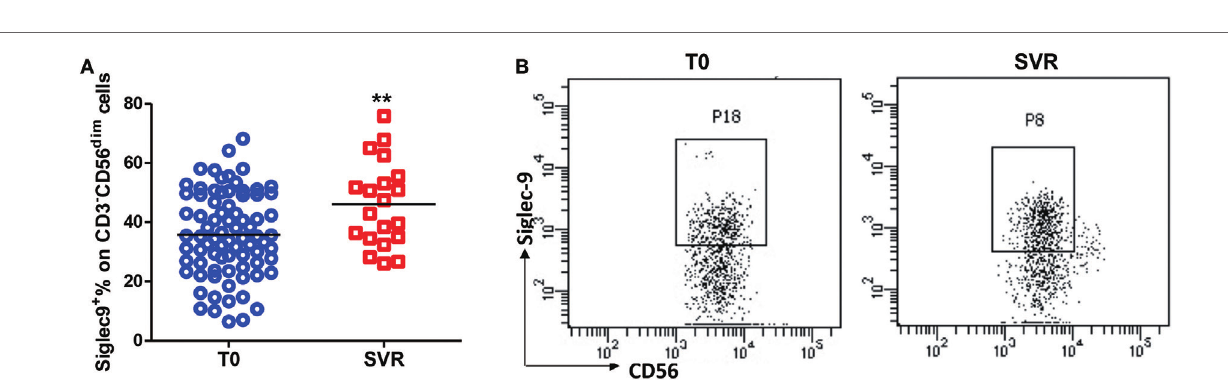
FigUre 2 | Negative correlation between Siglec-9 expression on NK cells and HBV viremia in chronic hepatitis B (CHB) patients. (a,c) Association of Siglec-9 expression on CD3 − CD56 + NK cells with serum hepatitis B e antigen (HBeAg) levels and HBV DNA in CHB patients. p Values are shown. (B,D) Association of Siglec-9 expression on CD3 − CD56 dim NK cells with serum HBeAg levels and HBV DNA in CHB patients. p Values are